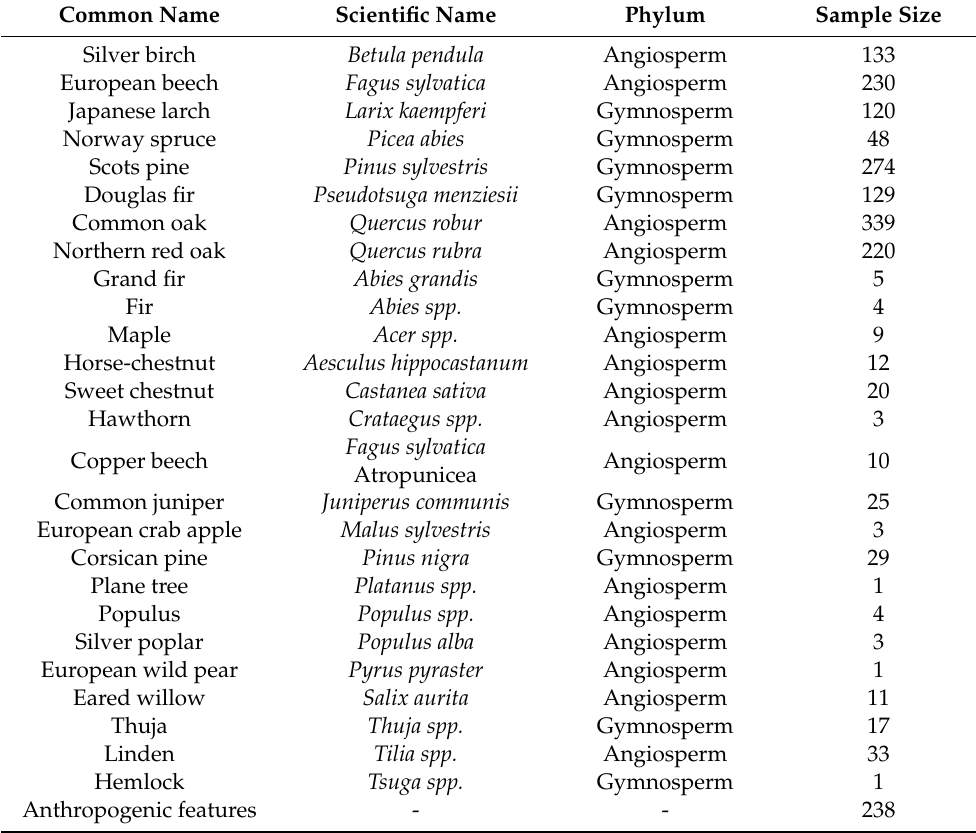
Table 3. Data (n = 1922) used in the random forest classification. The eight most common species and the anthropogenic features class were used into the species classification; the phylum classification included all